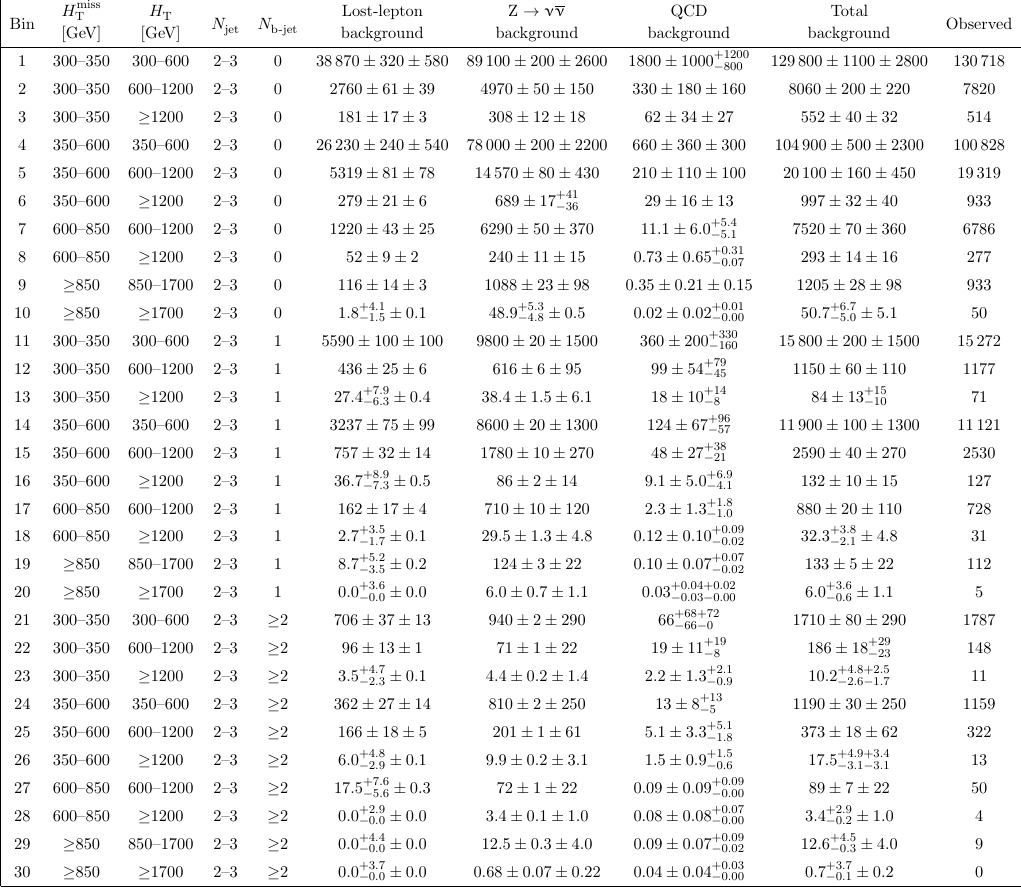
Table 3 . Observed number of events and pre-(cid:12)t background predictions in the 2 (cid:20) N bins. For the background predictions, the (cid:12)rst uncertainty is statistical and the second